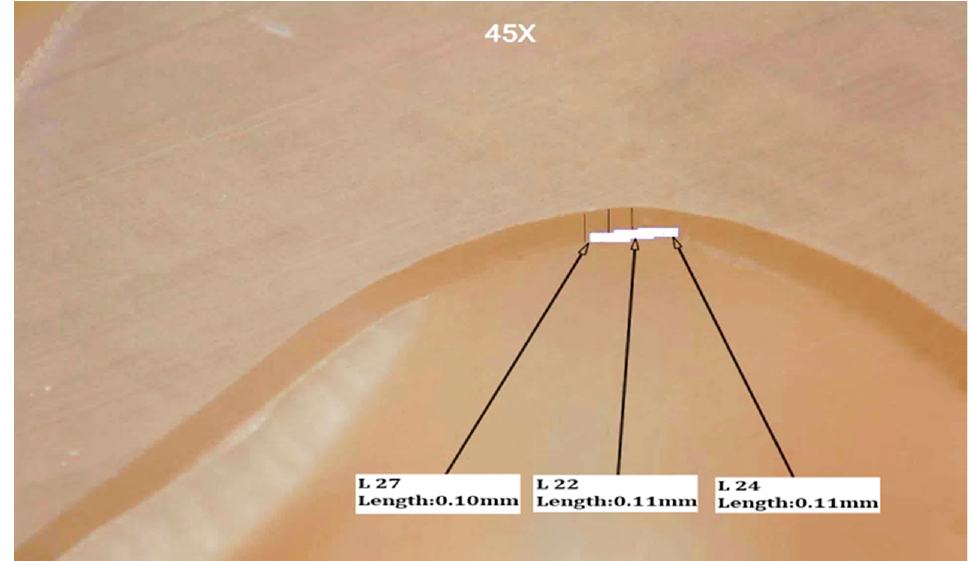
Figure 5. Stereomicroscopic view (45X) represents marginal and internal fit of a sectioned specimen at buccal cusp tip.